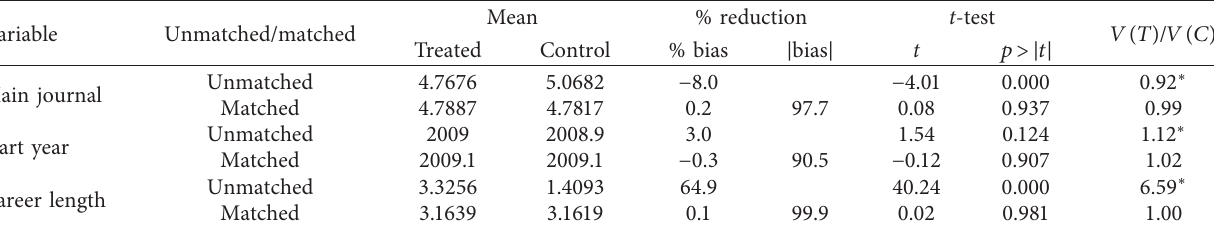
Table 9: Degree centrality balance test.